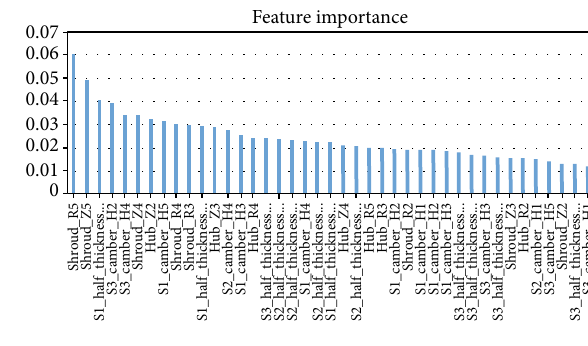
Figure 7: Feature